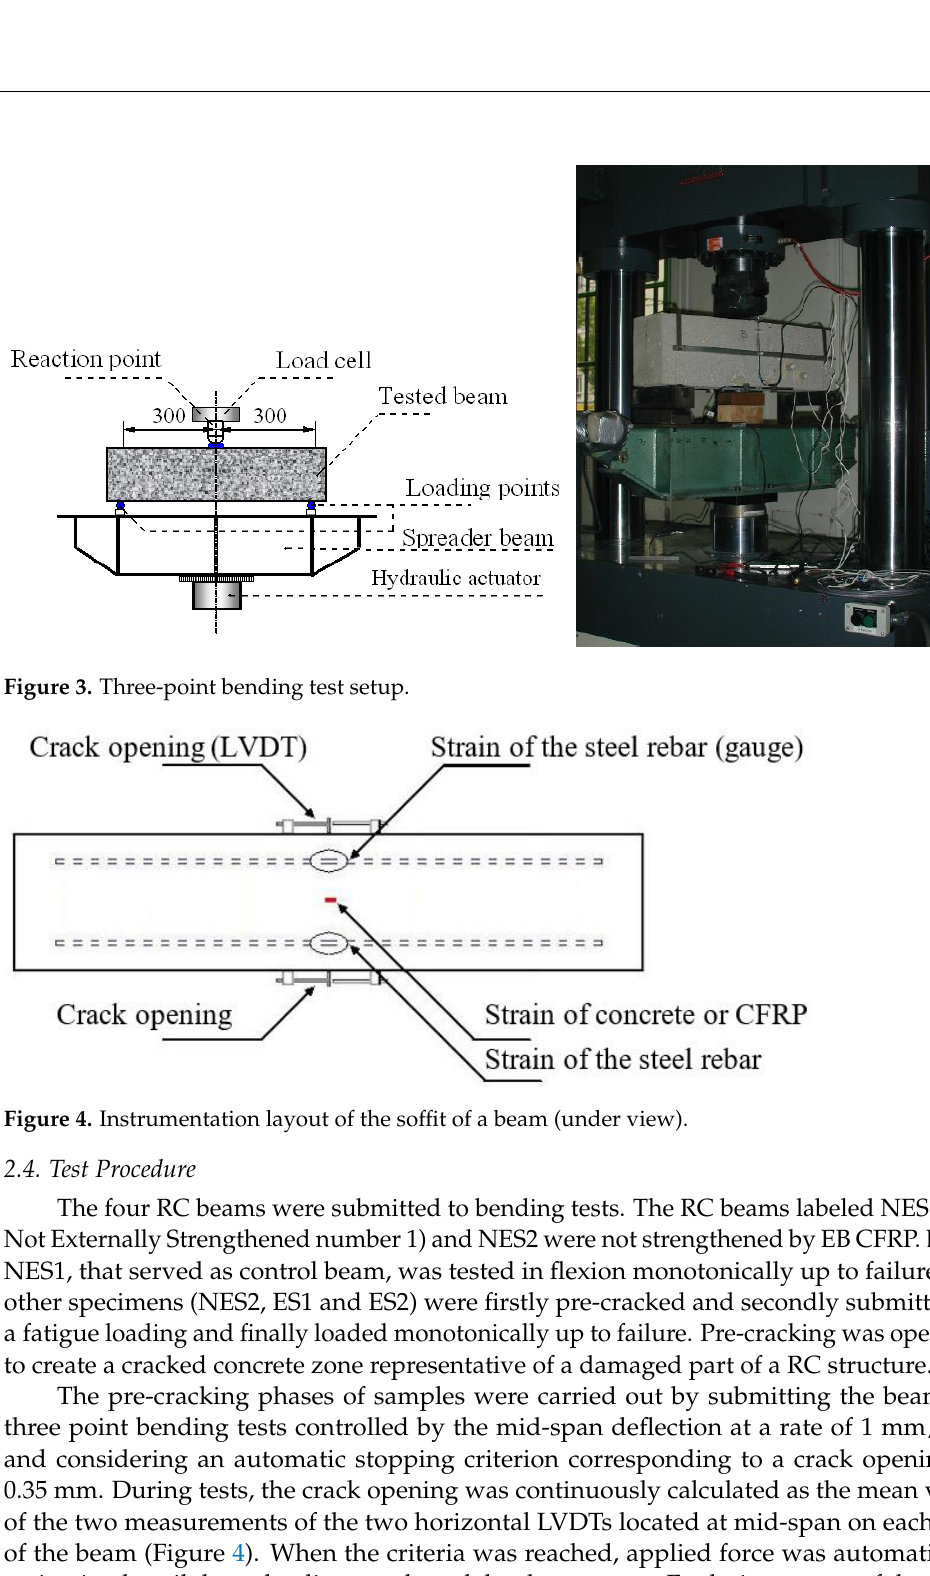
Figure 4. Instrumentation layout of the soffit of a beam (under view).